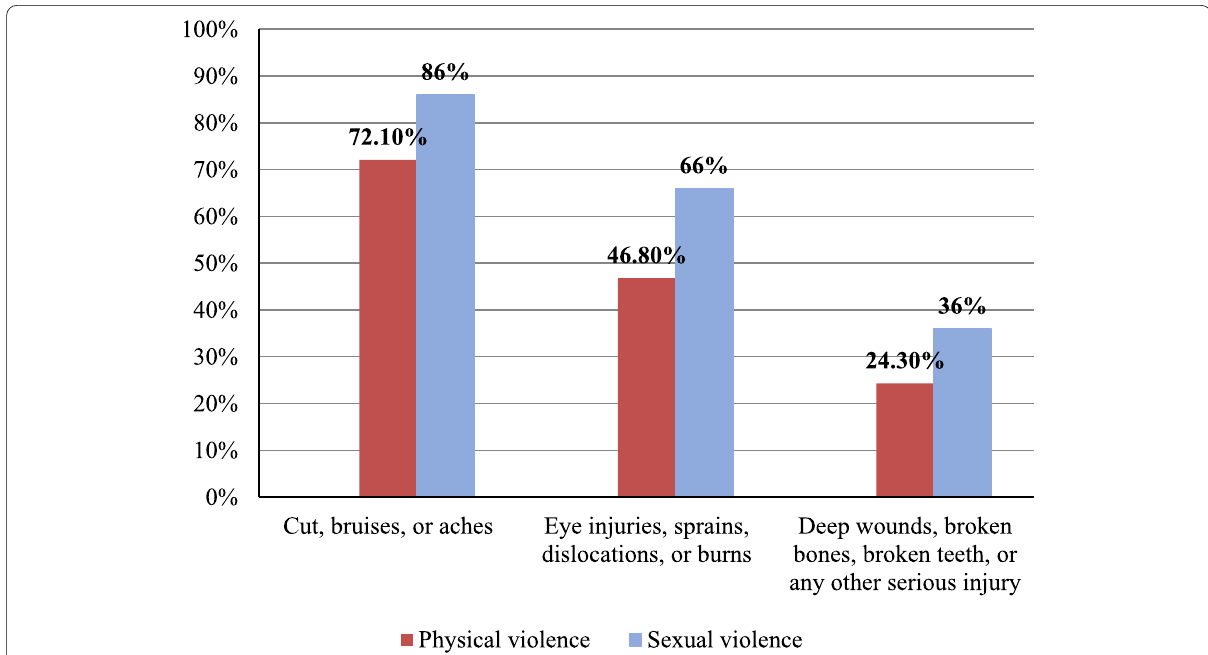
Fig. 4 Percentage of injuries resulting from different forms of violence among the studied women in eight governorates, Egypt, 2020